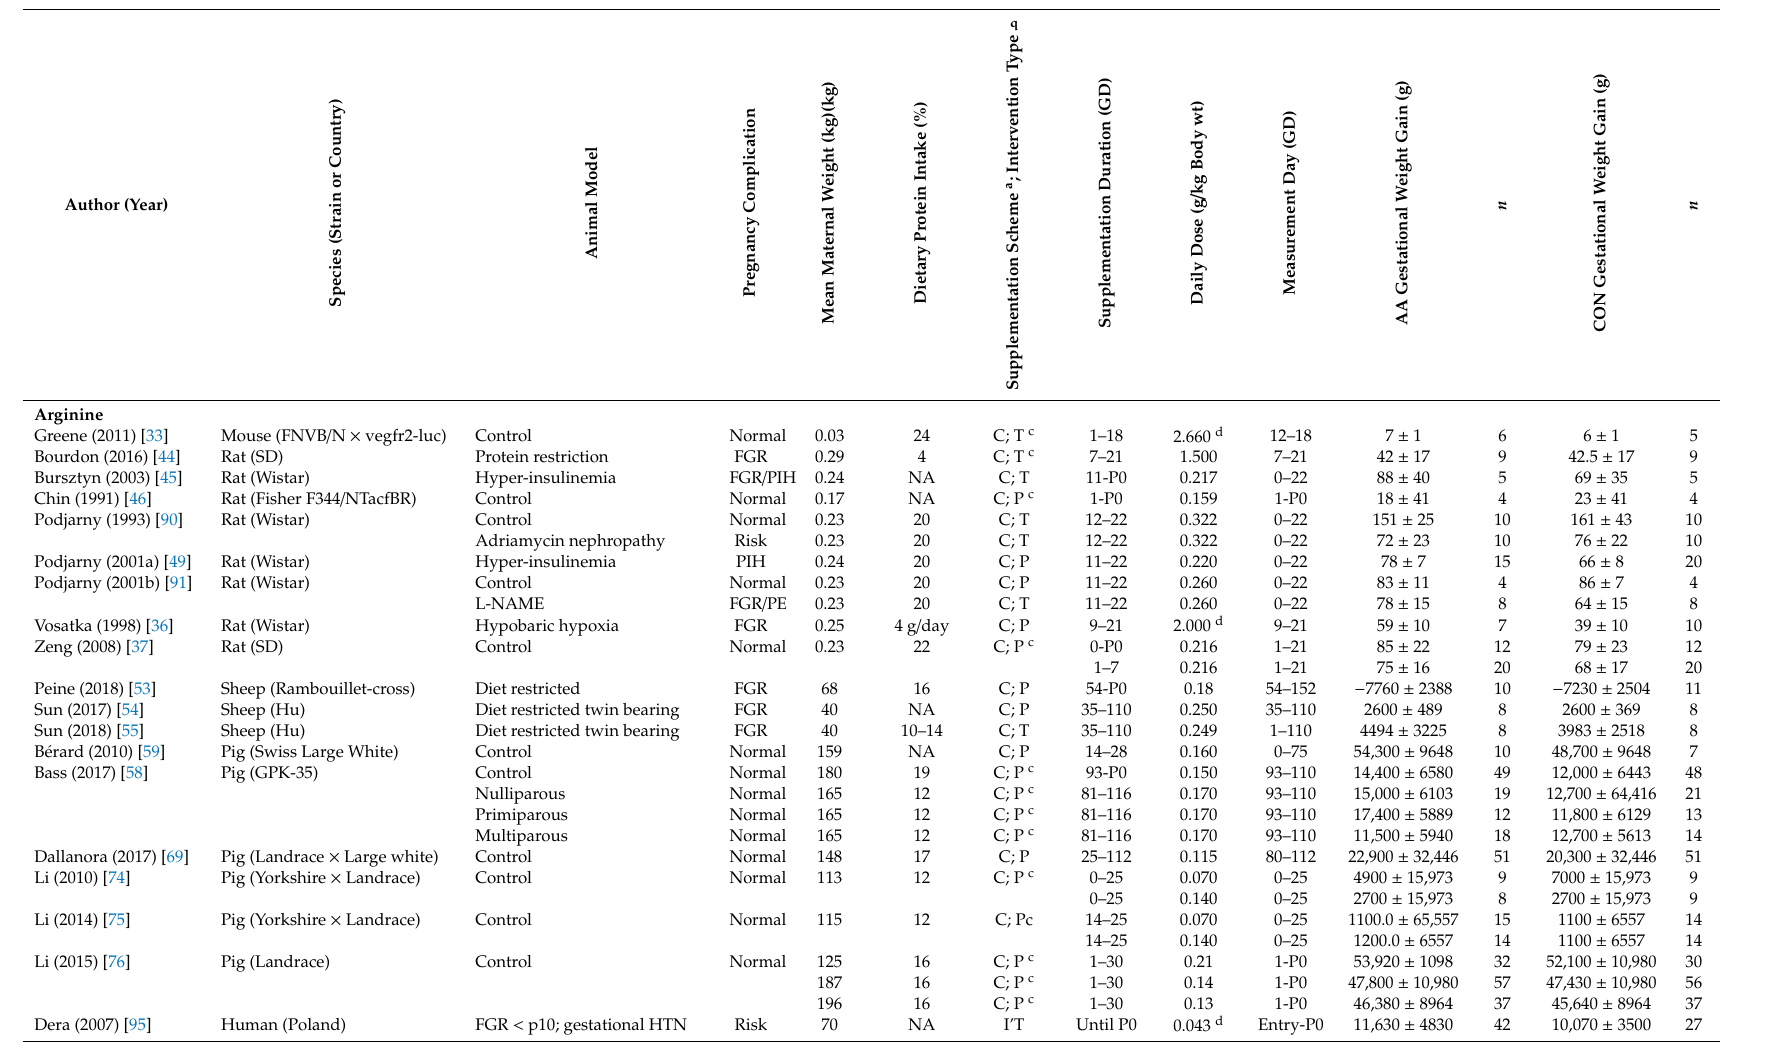
Table A8. Data extraction included animal and human studies on gestational weight